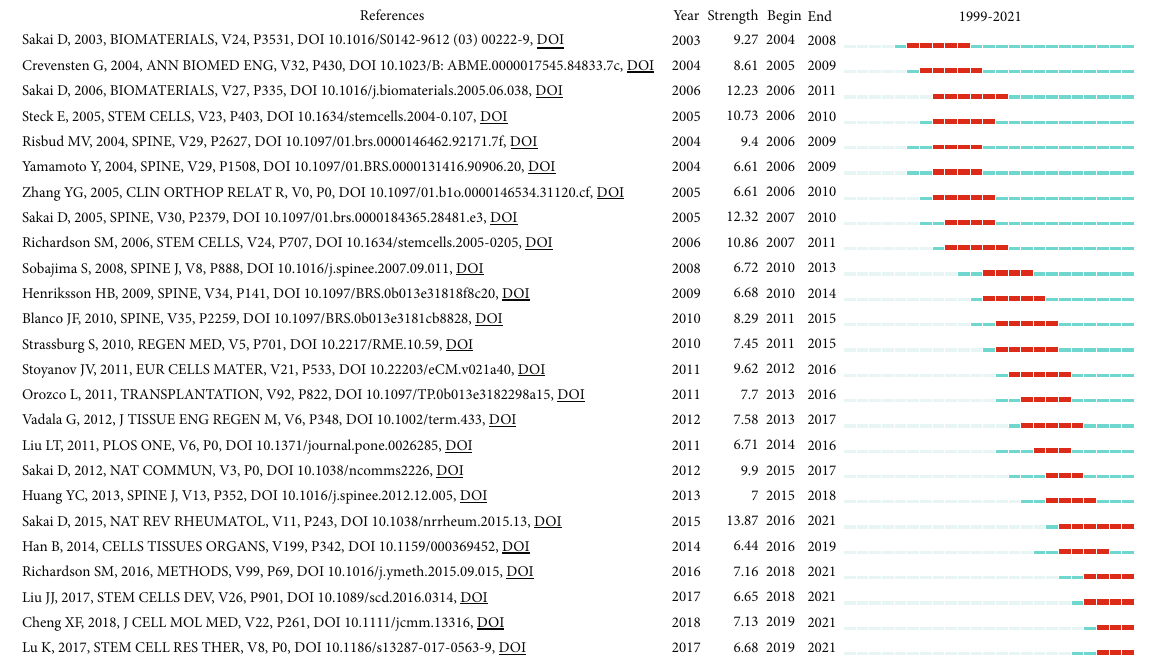
Figure 6: Top 25 references with the strongest citation bursts on stem and progenitor cells in intervertebral discs.